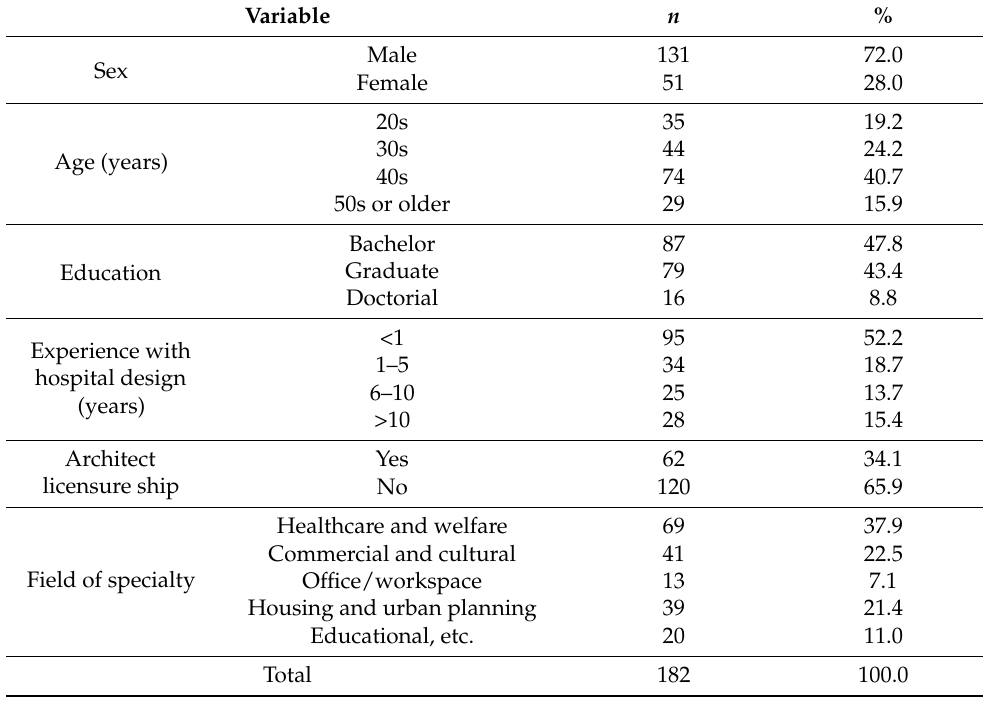
Table 2. Survey respondents’ personal and professional characteristics.